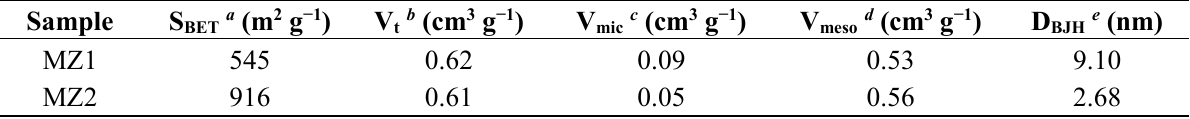
Figure 3. ( a , c ) Adsorption-desorption isotherms of nitrogen at 77 K for MZ1, MZ2, SBA-15 and MCM-41 samples; ( b , d ) Pore-size distribution of these materials. Table 1. Physical properties of porous